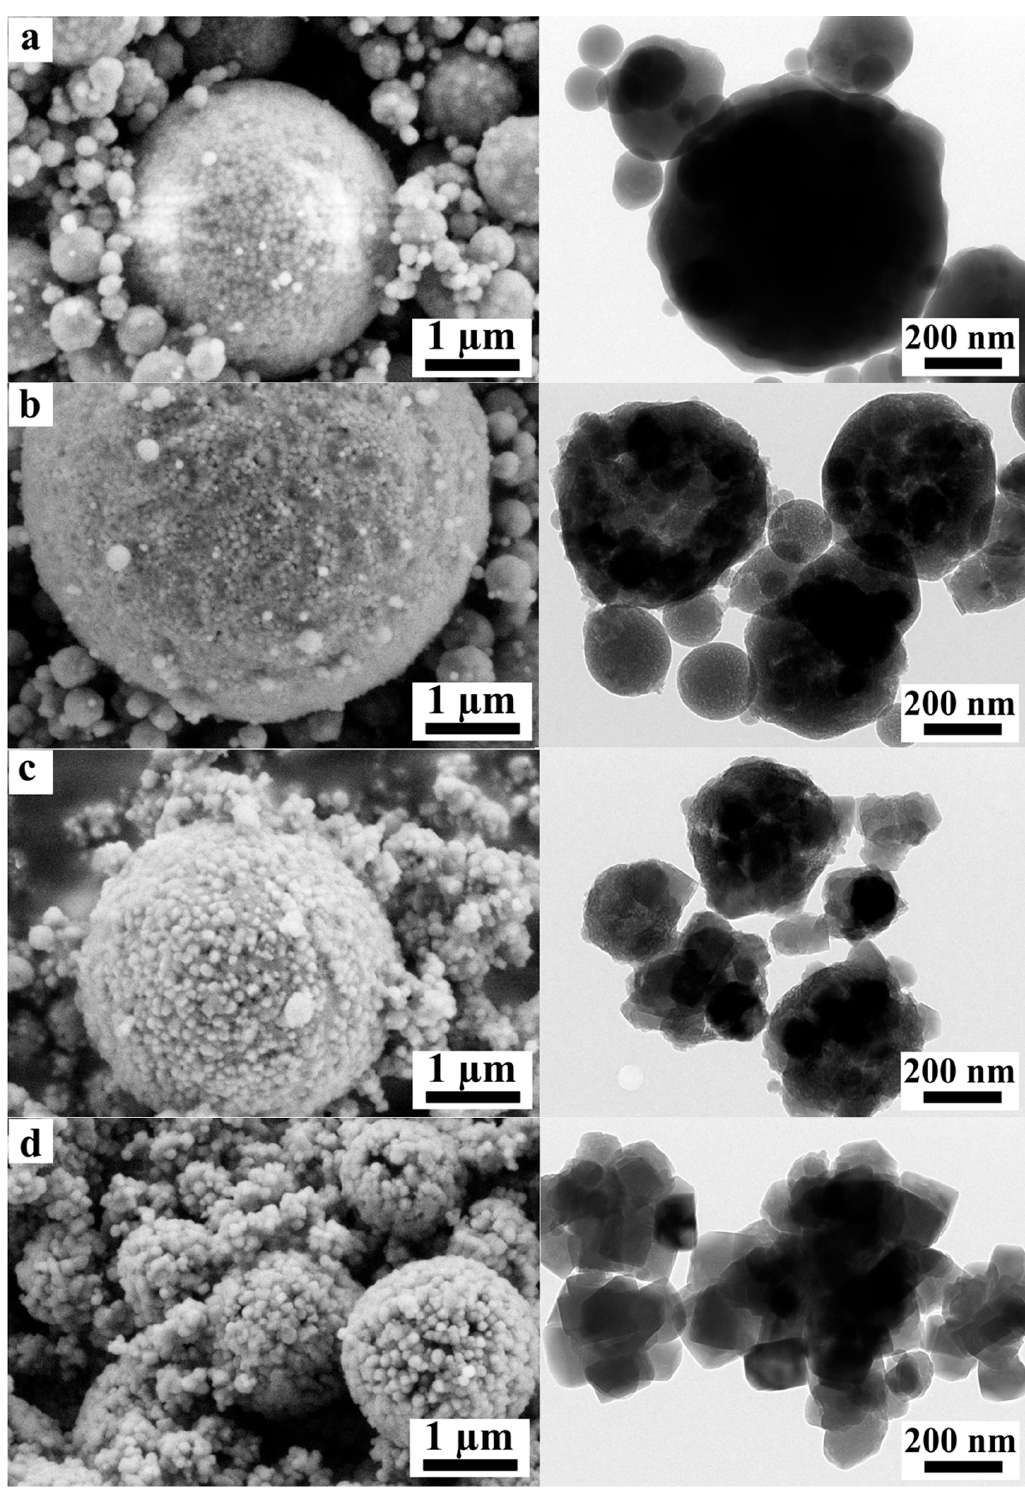
Figure 9. SEM ( left ) and TEM ( right ) images of the spray-dried particles before the SAC ( a ) and after 12 h ( b ), 48 h ( c ), and 192 h ( d ) of SAC. SAC was performed at 150 °C and resulted in formation of pure nanosized ZSM-5 aggregates.